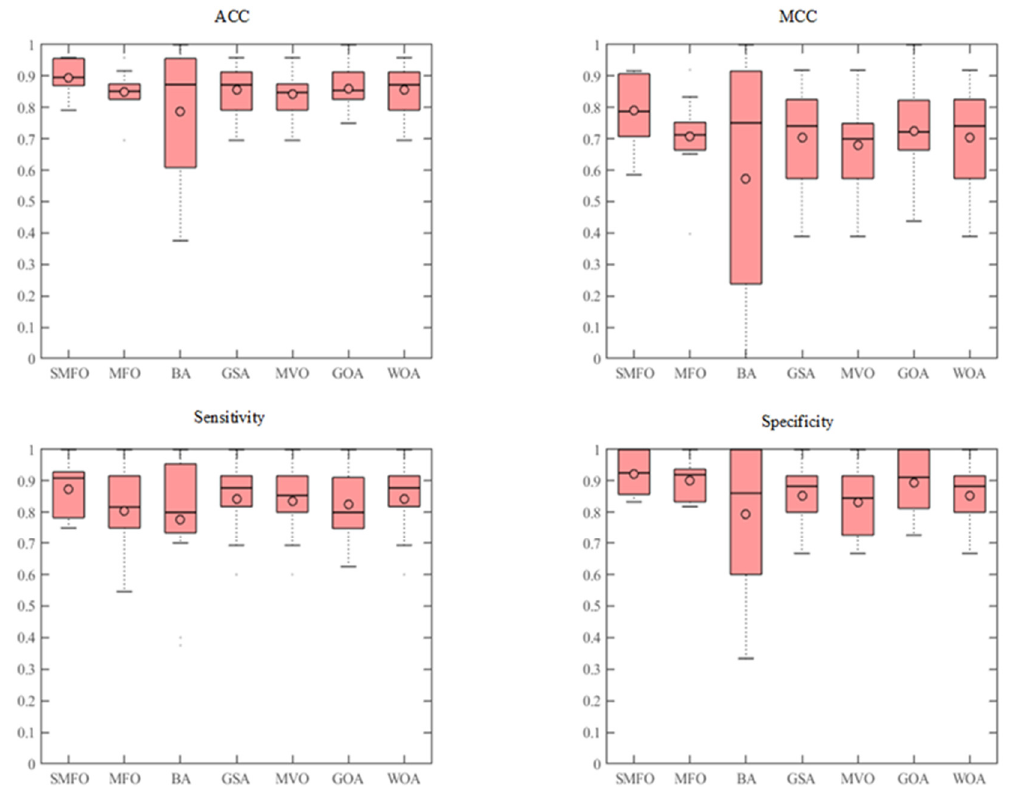
Figure 6. Boxplot of SMFO-KELM and its classical primitive algorithm competitors of ACC, MCC, sensitivity, and specificity on Son La dataset.